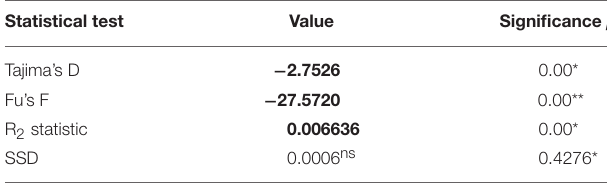
TABLE 4 | Values of hierarchical AMOVA analysis of DS 1. TABLE 5 | Results of neutrality tests of demographic parameters for dataset